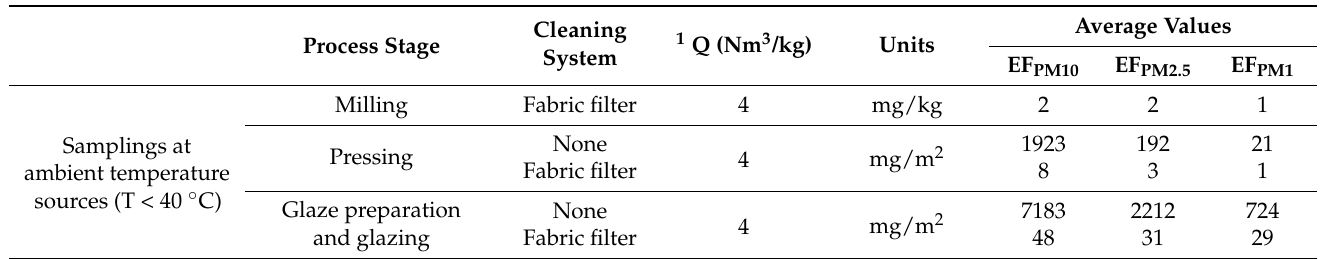
Table 6. Emission factors for milling, pressing, and glaze preparation and glazing (ambient- temperature processes).